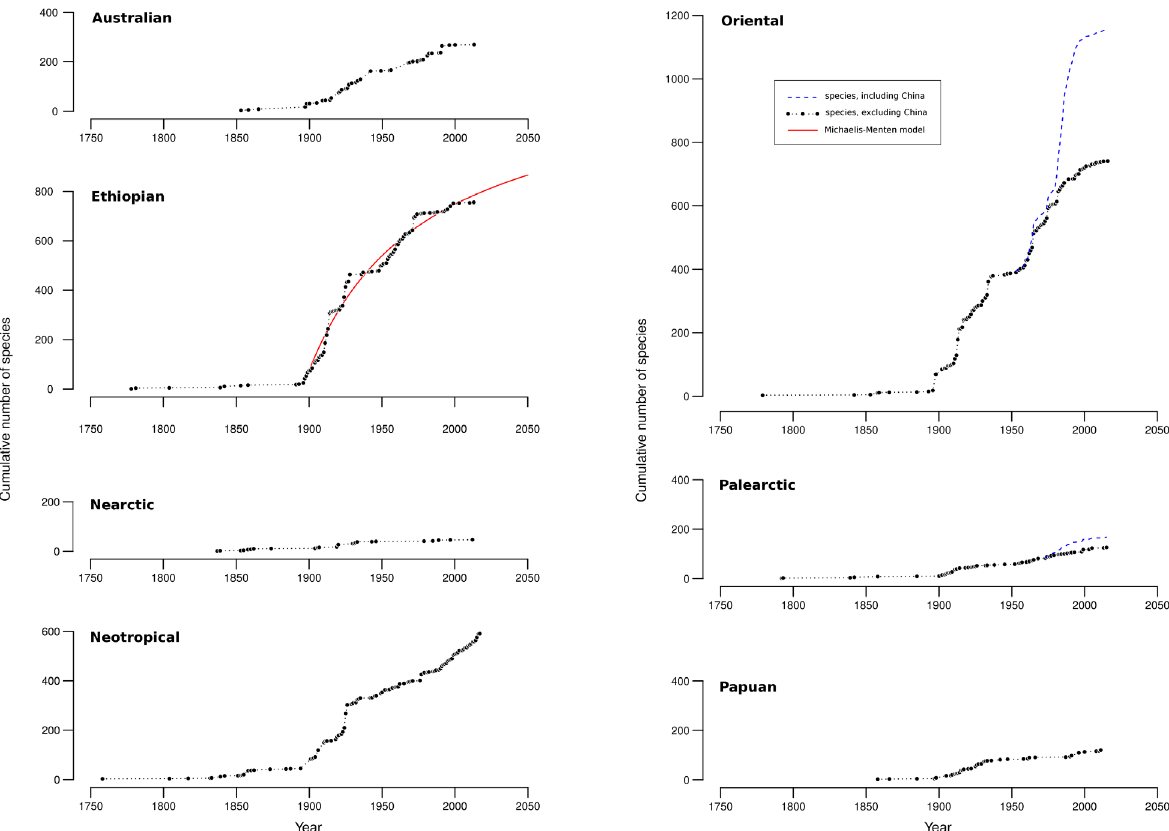
Fig 3 . Cumulative number of termite species since Linnaeus (1758) for each biogeographic region: Australian, Ethiopian, Nearctic, Neotropical, Oriental, Palearctic, and Papuan. Data from China is shown as a separate line for the Oriental and Palearctic regions. The Michaelis-Menten model is shown only for the Ethiopian